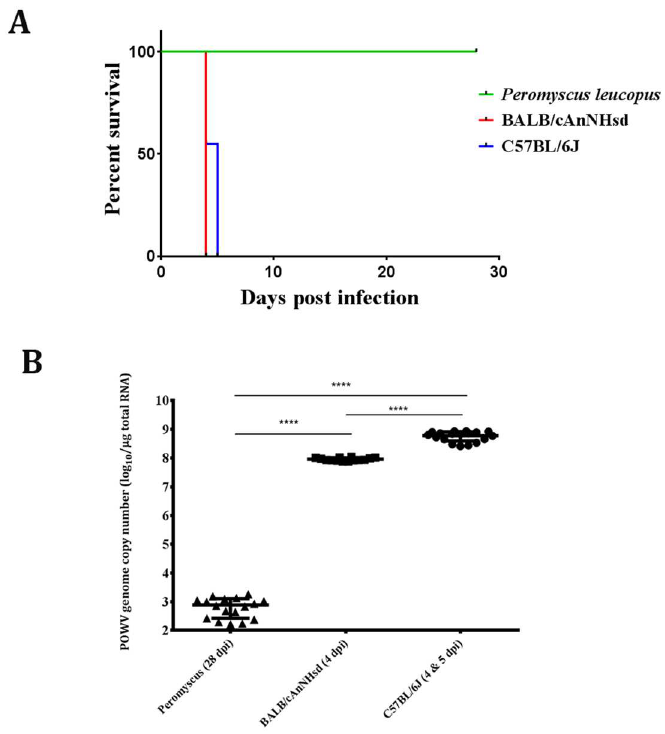
Fig 1. Outcomes of i.c. inoculation of POWV. (A) Survival curve of P . leucopus , BALB/c and C57BL/6 mice after i.c. inoculation. (B) Terminal POWV (+)RNA copy numbers in brain homogenates determined by qPCR. 28 dpi copy numbers are presentedfor P . leucopus becausethese mice survived to the experimental end- point, set at 28 days. **** p <